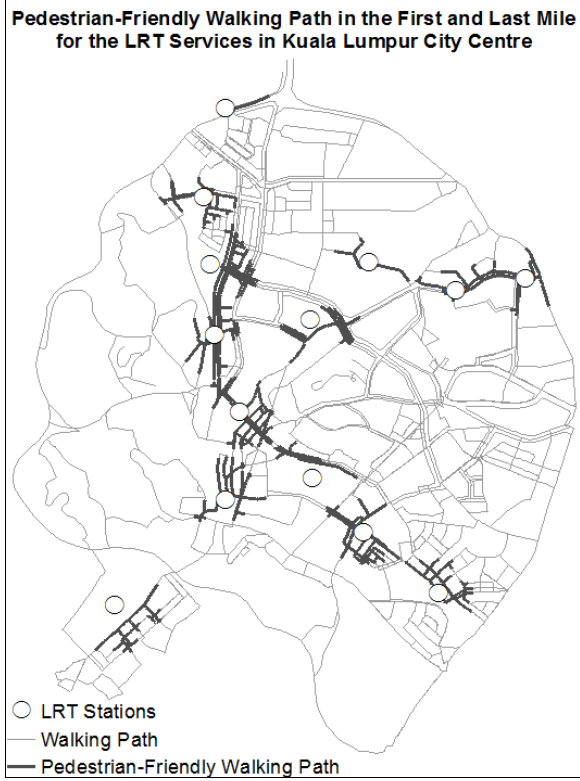
Figure 6: Map of Pedestrian-Friendly First/Last Mile Transit Route around LRT